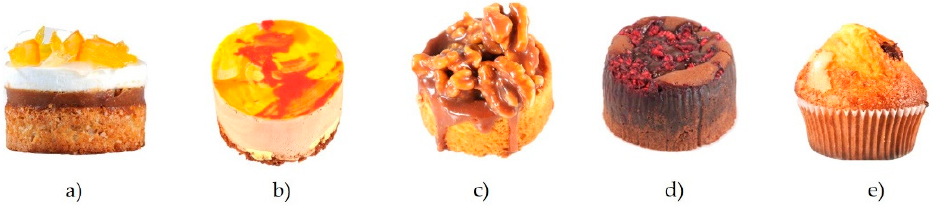
Figure 1. Stimuli designed by “Casa La Curra”: ( a ) Leonor cake (LC); ( b ) Saffron cake (SC); ( c ) Walnut cake (WC); ( d ) Coulant cake (CC); ( e ) Chocomuffin (CM). Pictures were taken with a Nikon D300 camera with Nikkor 24–70mm f/2.8S objective (Nikon Corporation, Tokyo, Japan). A white uniform background and three led panel light Neewer (Shenzhen Neewer Technology Co, Shenzhen, China) were used to ensure